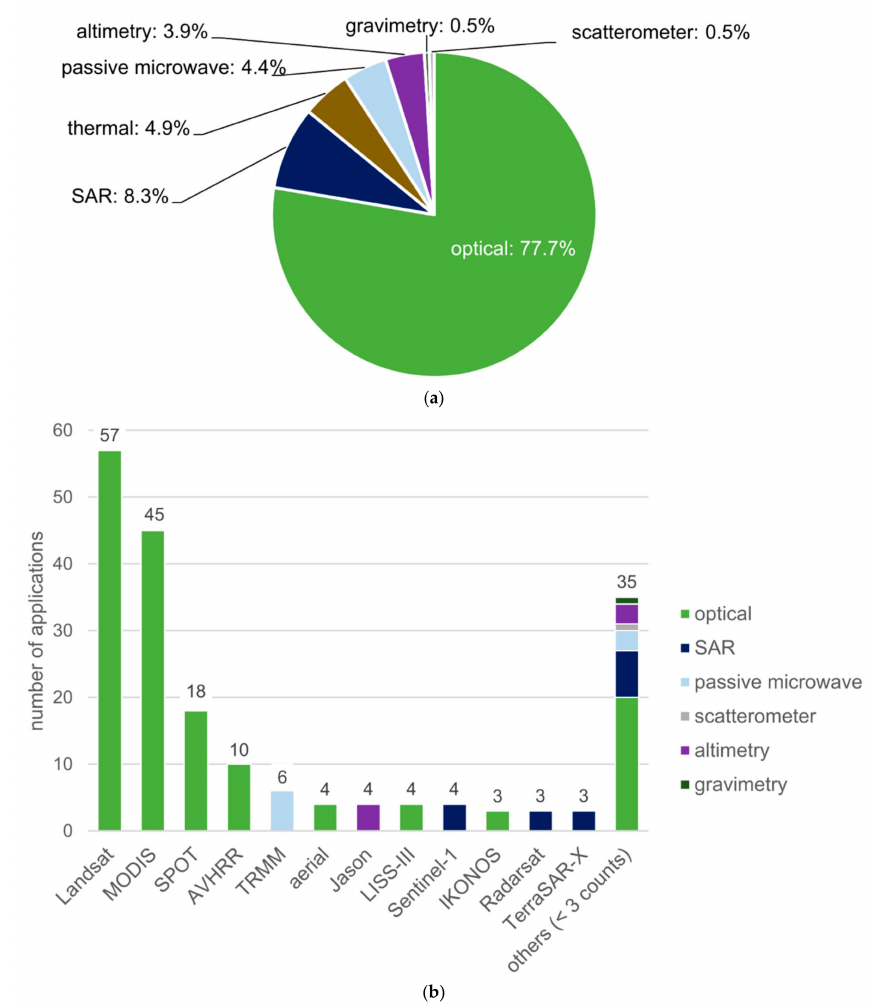
Figure 12. Remote sensing sensor types and sensor systems used for EO-based forecasting: ( a ) Number of sensor types applied; ( b ) Number of sensor system families applied. All aerial data used in the reviewed studies is optical. Some sensor systems o ff er multiple sensor types which is considered in ( a ) but not in ( b